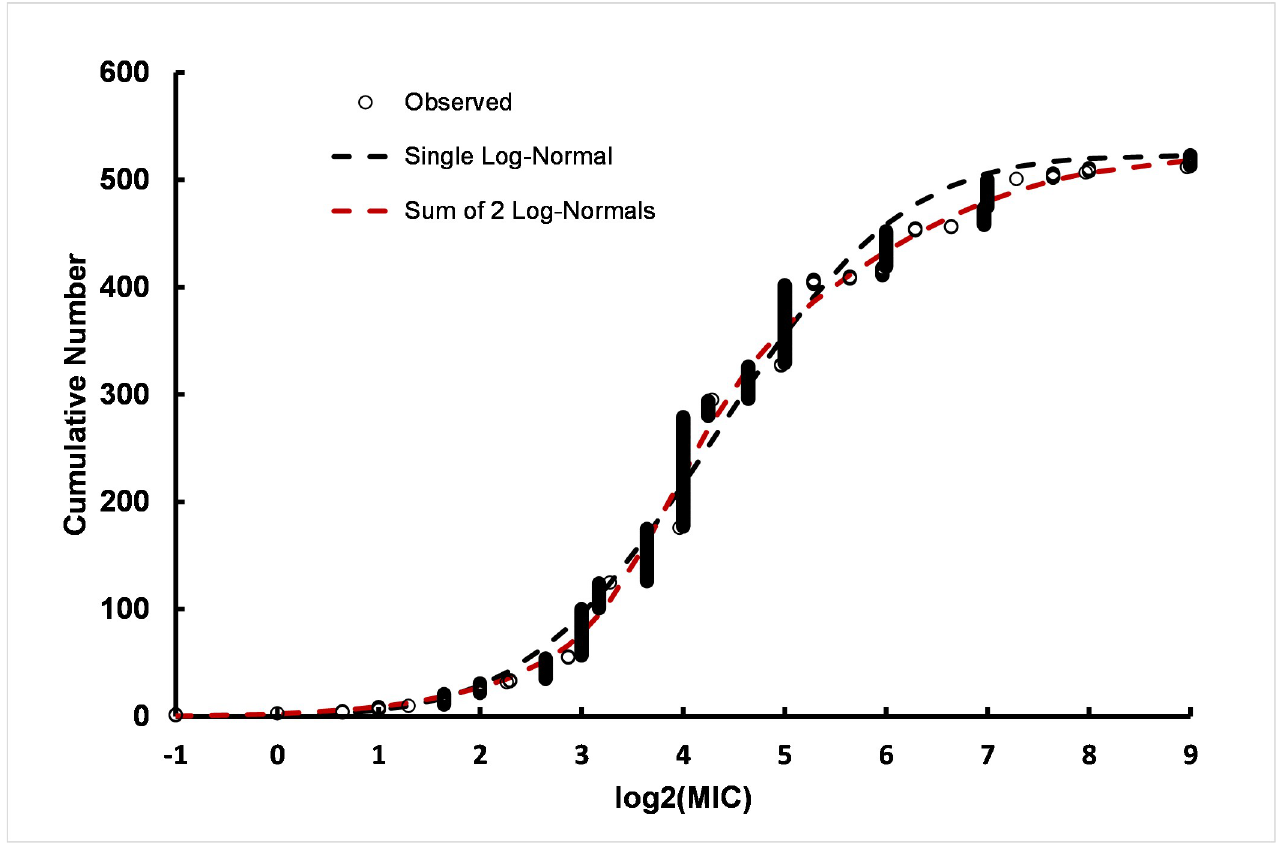
Fig 7. Fits of a single log-normal and the sum of two log-normal distributions to MIC data from A . baumannii strains isolated on all dates. Parameter values for the best fit are presented in the main text and details for the comparison of fits is given in S9 Table in S2 Appendix.